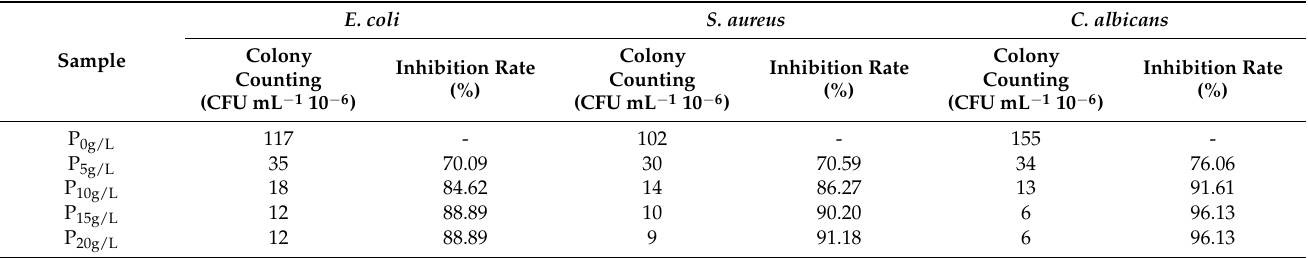
Table 5. Inhibition rates of untreated cotton and antimicrobial cotton against E. coli , S. aureus , and C. albicans